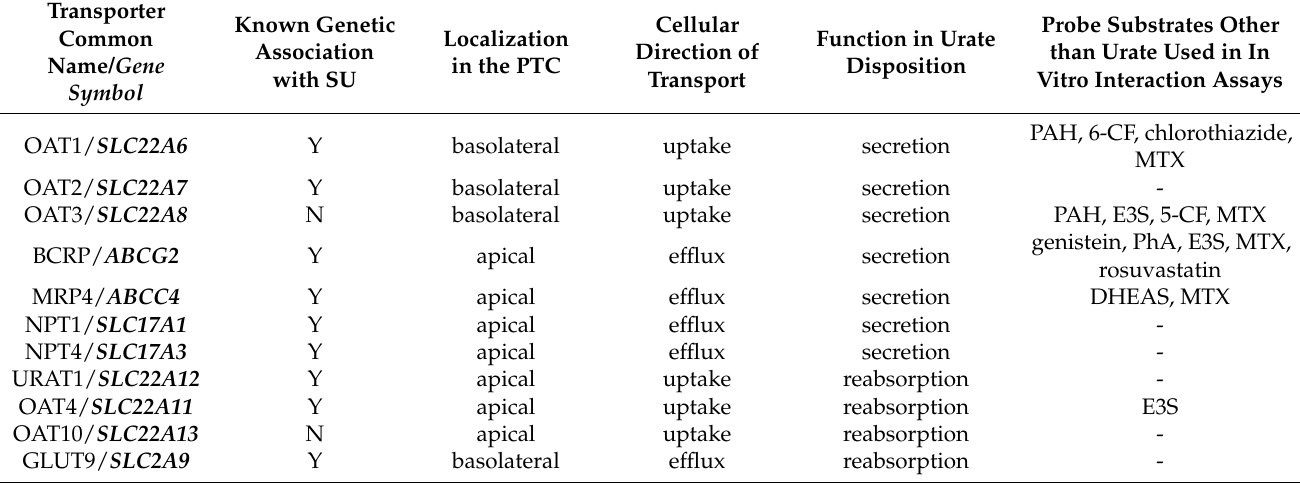
Table 1. Transporters involved in urate disposition. Abbreviations: 5-/6-CF, 5-/6-carboxyfluorescein; DHEAS, dehy- droepiandrosterone sulfate; E3S, estrone 3-sulfate; MTX, methotrexate; PAH, p -aminohippuric acid; PhA, pheophorbide A; PTC, proximal tubule cells; SU, serum